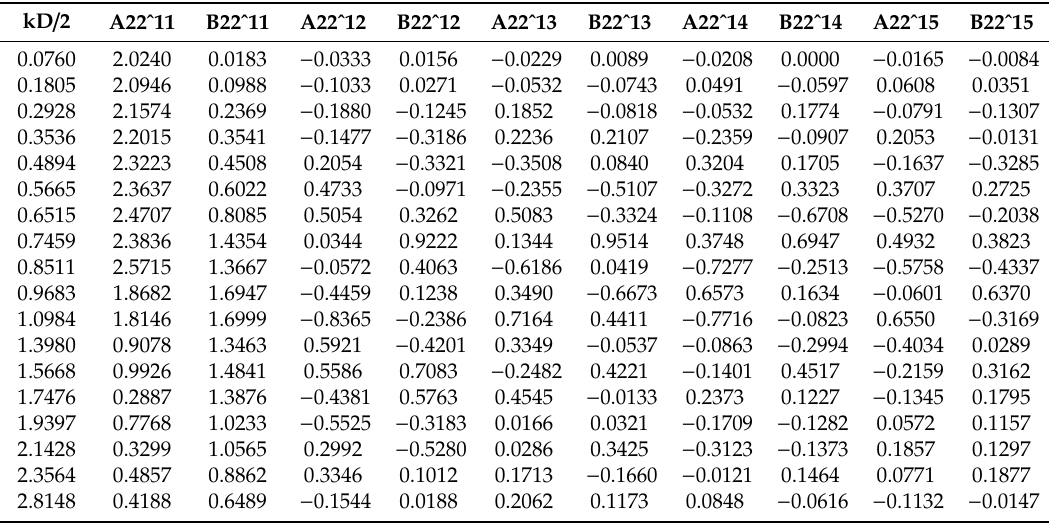
Table A4. Hydrodynamic characteristics of the 1st floater of the array of five cylindrical floaters.